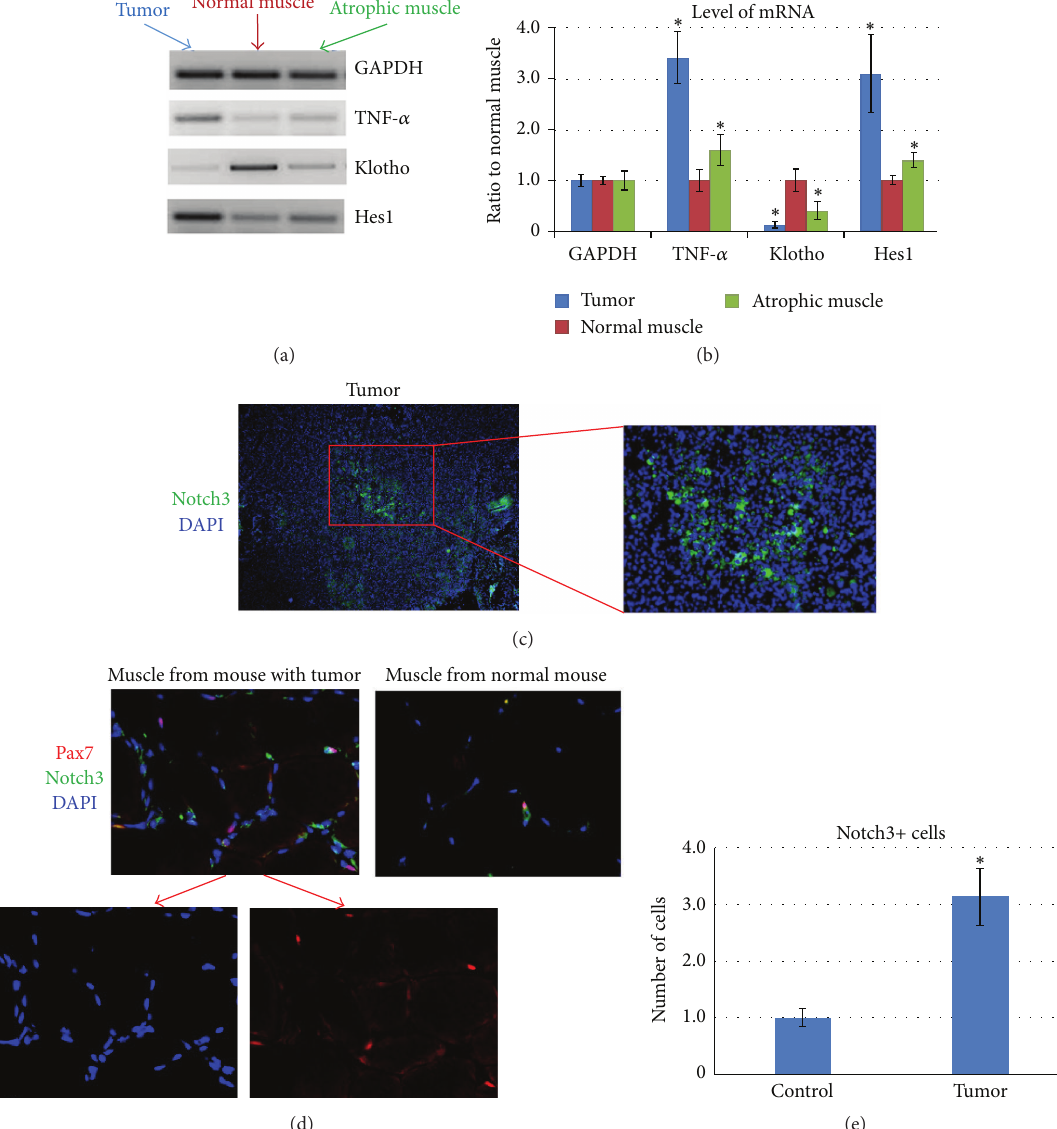
Figure 3: Increased Notch activation in both tumor tissues and skeletal muscle of tumor-bearing mice. (a) Semiquantitative PCR showed the gene expression of TNF- 𝛼 , Hes1, and Klotho in tumor, normal muscle, and atrophic muscle. (b) mRNA levels of TNF- 𝛼 , Hes1, and Klotho in 3 types of tissues. “ ∗ ” in the bar chart indicates 𝑃 < 0.05 compared to normal muscle. (c) Immunostaining of tumor tissue with antibody to Notch3, showing enrichment of Notch3+ cells in tumor. (d) Immunostaining of muscle tissue with antibody to Notch3 and Pax7, showing increased numbers of Pax7+ cells, Notch3+ cells, and Pax7+/Notch3+ cells in the muscle of tumor-bearing mice. The colocations of Pax7 and DAPI are indicated with arrows in the images. (e) The quantification of Notch3+ cells in muscle of normal mice (control) and mice bearing tumor (tumor). “ ∗ ” in the bar chart indicates 𝑃 < 0.05